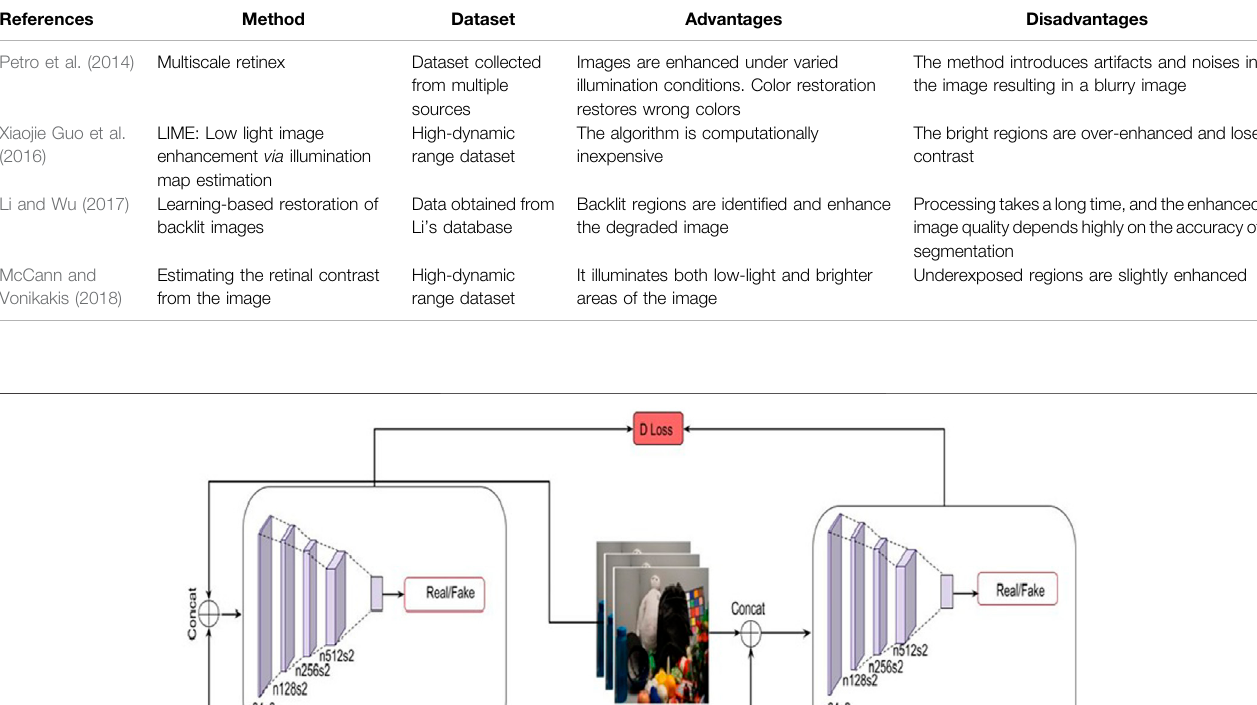
TABLE 1 | Advantages and disadvantages of existing low-light image enhancement techniques.